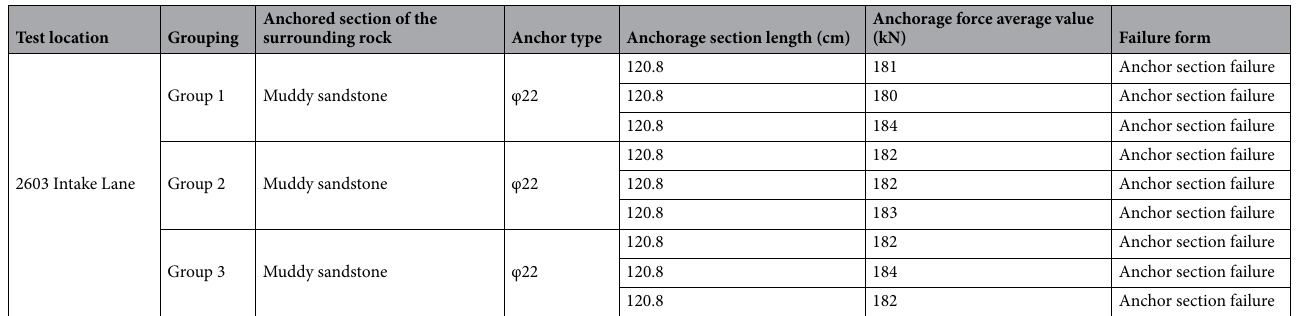
Table 2. Bolt pullout test results of the 2603 air inlet roadway in the Zhangcun coal mine.